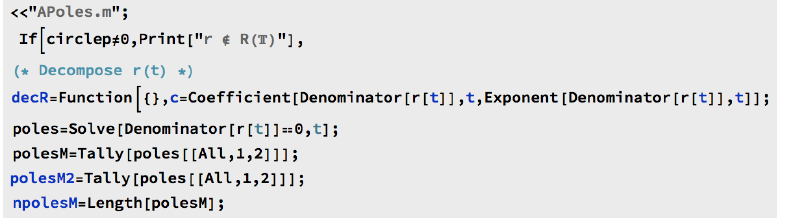
Figure 48. Part of the code structure of the [ASPPlusPMinus] algorithm that integrates the [APoles] algorithm and uses Mathematica ’s Solve command.